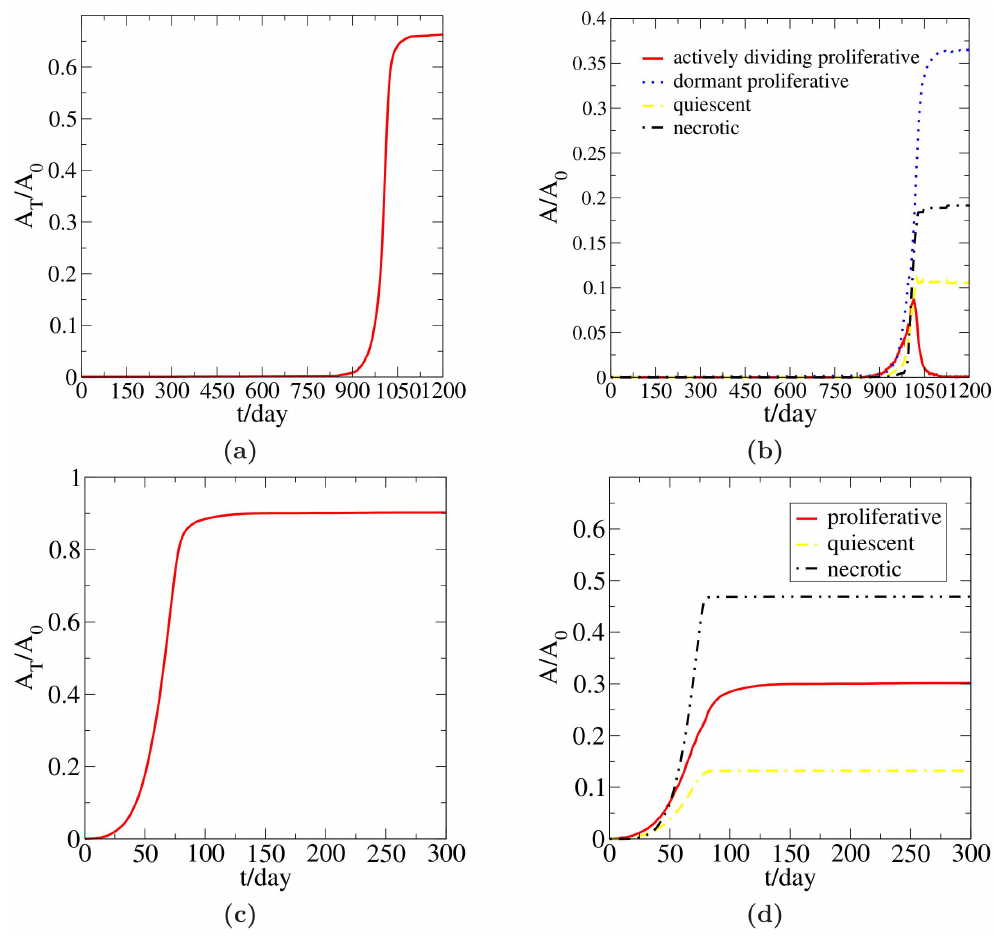
Figure 2. Upper panel: statistics of a simulated noninvasive tumor growing in the ECM with (cid:2) rr ECM ~ 0 : 3 and microenvironmental suppression factors, as predicted by the ‘‘CA dormancy model’’. (a) Tumor area A T normalized by the area A 0 of the growth permitting region. (b) Areas of different cell populations normalized by the area A 0 of the growth permitting region. Lower panel: statistics of a simulated noninvasive tumor growing in the ECM with (cid:2) rr ECM ~ 0 : 3 without suppression. (c) Tumor area A T normalized by the area A 0 of the growth permitting region. (d) Areas of different cell populations normalized by the area A 0 of the growth permitting region.